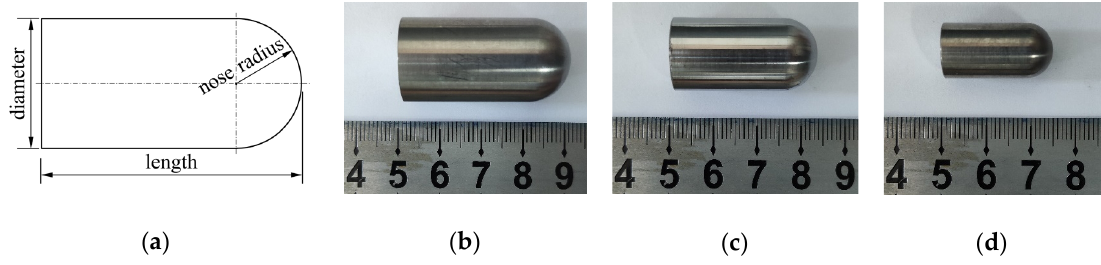
Figure 1. Dimensions and photographs of projectiles: ( a ) schematic of dimensions of projectile; ( b ) photograph of TC4 projectile; ( c ) photograph of 30CrMnSiA projectile; ( d ) photograph of 93 W projectile.